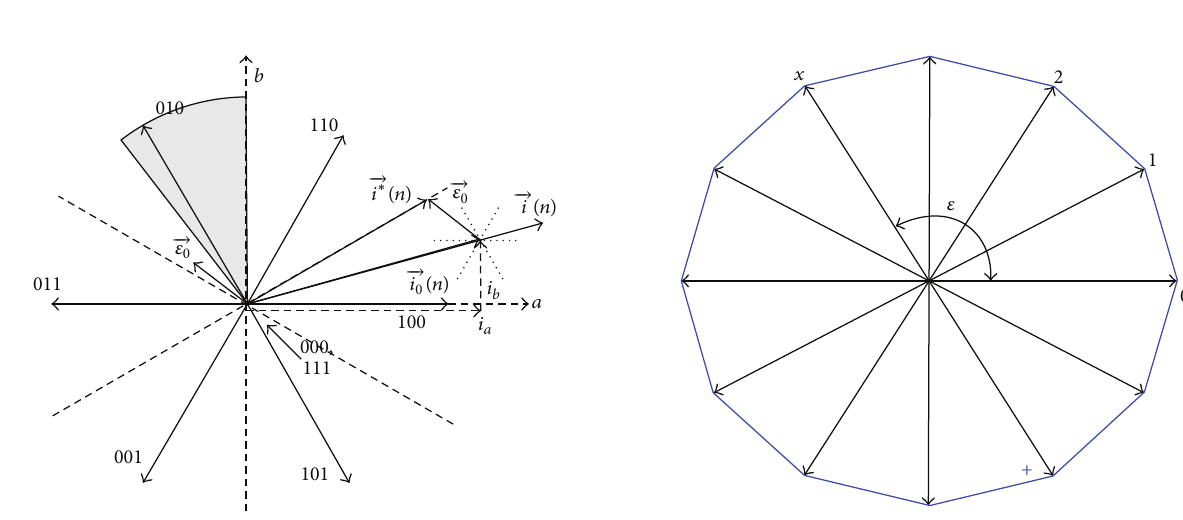
Figure 5: Block diagram of stator current oriented control system PMSM.